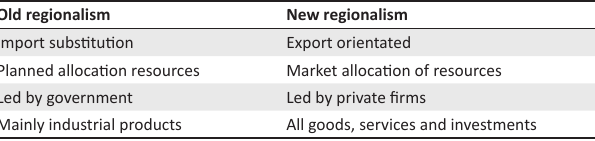
TABLE 1: Lawrence’s comparison of old and new regionalism. Old